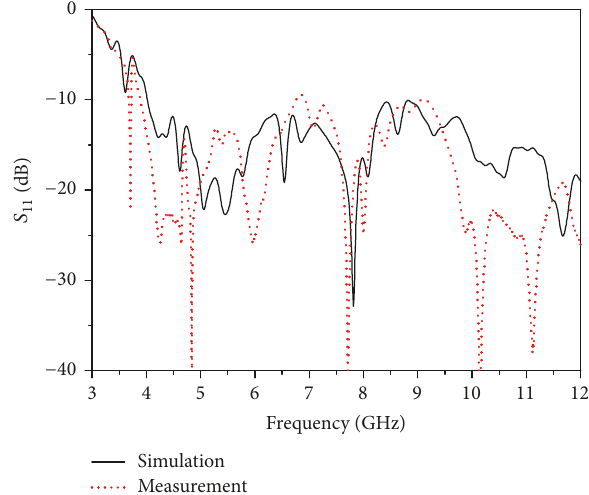
Figure 13: Simulated and measured 𝑆 11 of the fabricated